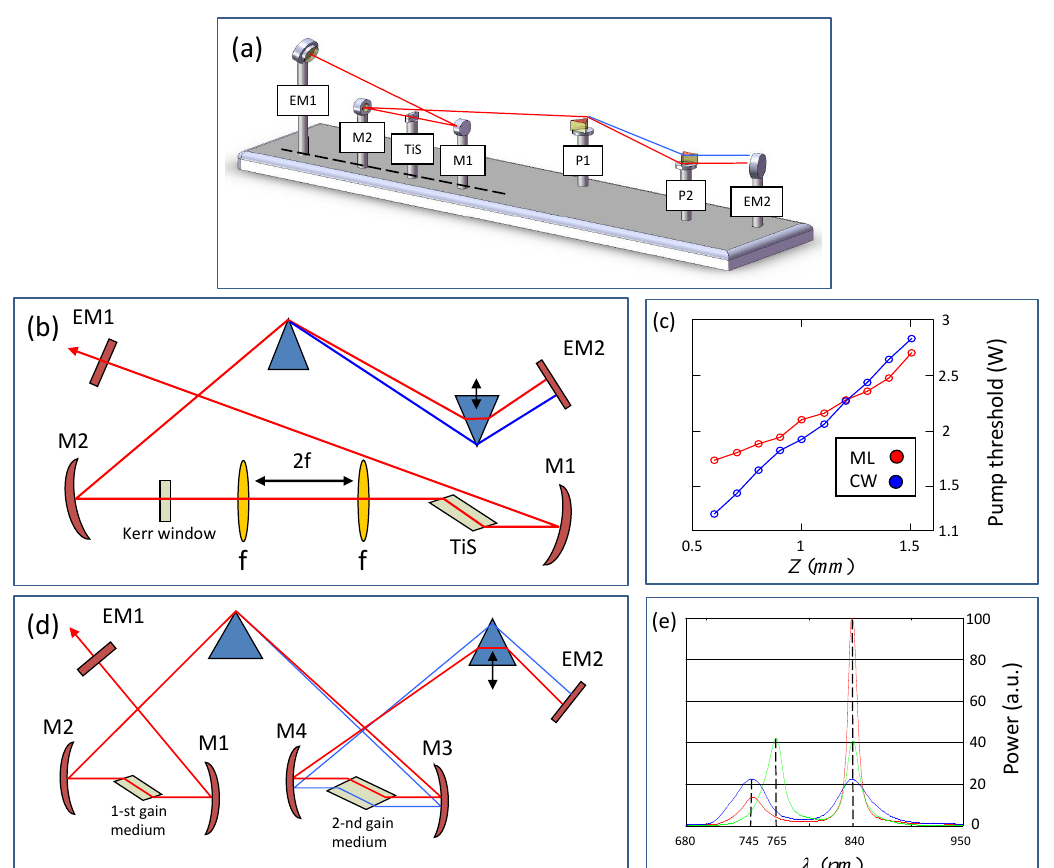
Figure 11. ( a ) Cavity configuration for canceling the nonlinear astigmatism. The long arm remains parallel to the main plane of the cavity, while the short arm is raised above the main plane, allowing for each of the curved mirrors to compensate for the astigmatism of the other and to introduce a planar-cut astigmatic-free Ti:sapphire crystal. ( b ) Cavity configuration for enhancement of the intra-cavity Kerr nonlinearity. An additional planar-cut Kerr window is inserted near the image point of the Ti:sapphire crystal, created by a lens-based 1 × 1 telescope of focal length f . ( c ) The result for the configuration in ( b ): ML (red) and CW (blue) pump thresholds as a function of Z = δ − δ . The intra-cavity 1 nonlinearity was enhanced by adding a 3 mm-long window of borosilicate crown glass (BK7). At low values of Z , the ML threshold is higher than the CW threshold. By increasing Z , the ML threshold curve eventually crosses the CW threshold at Z ≈ 1.2 mm, where the c intra-cavity CW power needed to initiate pulsed operation drops to zero. ( d ) The cavity configuration for intra-cavity control of spectral amplitude. medium is placed at the Fourier plane of a 1 × 1 telescope (mirrors M 3 and M 4 ) placed between the prisms, resulting in an additional gain, which is effectively inhomogeneous, due to the spatial dispersion inside the medium, thereby eliminating mode competition in the gain medium. ( e ) The results for the configuration in ( d ): control of spectral power, width and center position of the two lobes; a two-lobed spectrum with equal intensities between the lobes (green curve) can be deformed in real time by increasing the width of each lobe (blue curve) or the spectral power ratio between the lobes (red curve). The center wavelength of each lobe can also be controlled by shifting the pump spot in the second crystal (demonstrated in both the blue and red